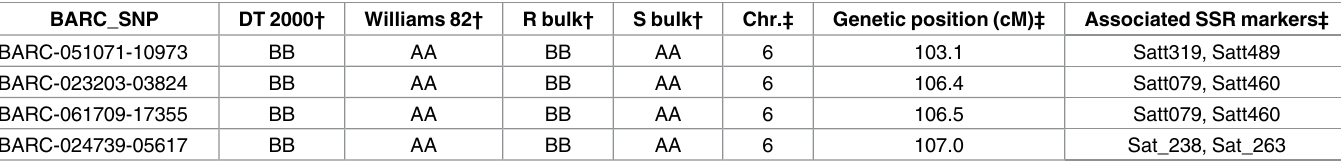
Table 2. Single nucleotide polymorphism markersdetected on the chromosome 6, co-segregating with the resistant and susceptible parental lines, DT 2000 and Williams 82, respectively, using bulked segregant analysis of recombinant inbred lines developed from a Williams 82 × DT 2000 cross.